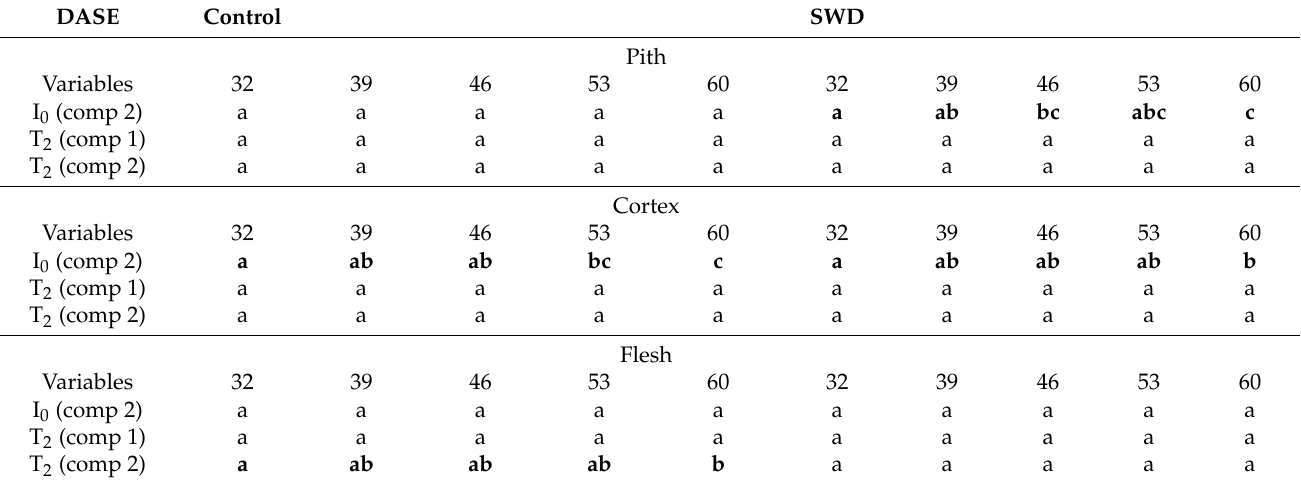
Table 6. Statistical evaluation of the effect of growth phase on MRI parameters (ANOVA test followed by the Tukey HSD test or the Kruskal–Wallis test followed by the Bonferroni test; Statgraphics, alpha = 5%). Different letters between 32, 39, 46, 53 and 60 DASE for the same growth condition indicate a statistically significant